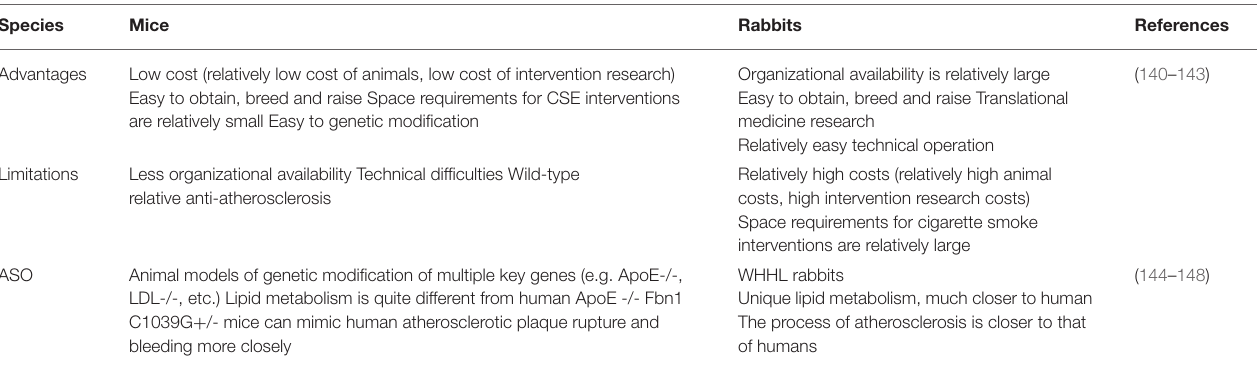
TABLE 2 | Advantages and limitations of mice and rabbits in animal models of ASO.